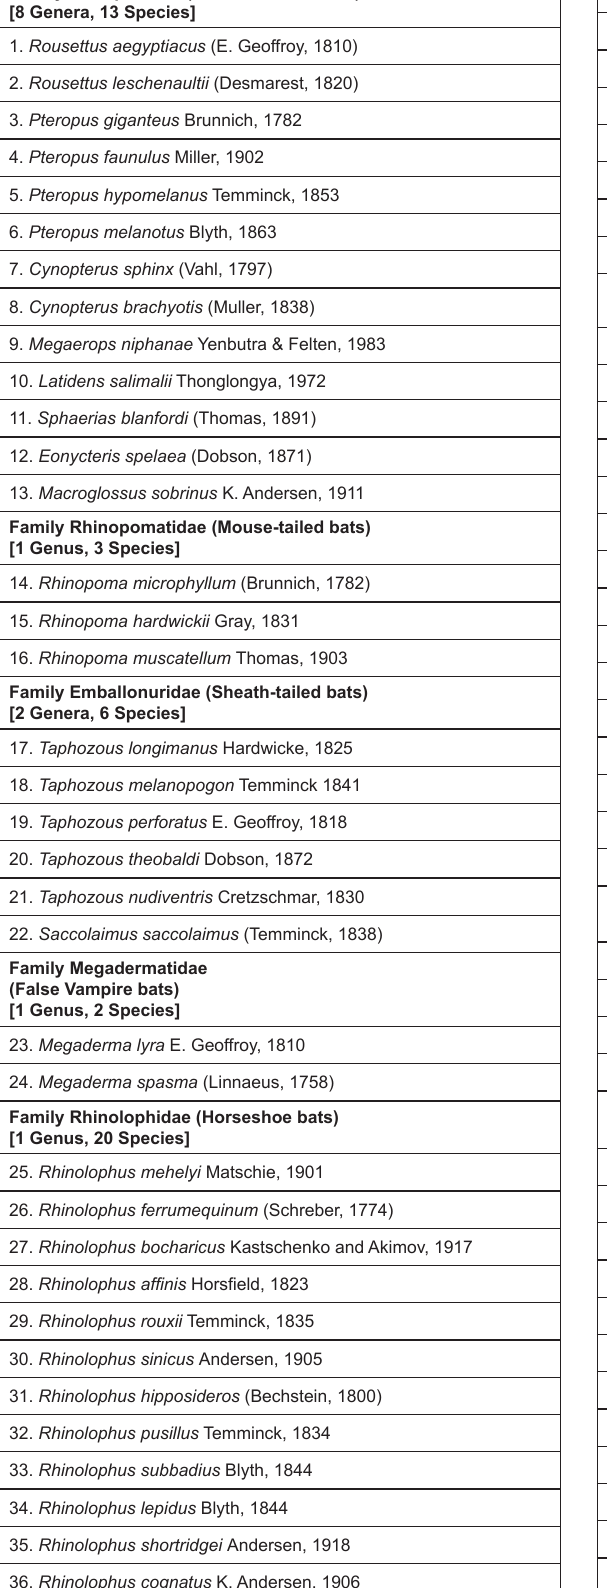
Table 2. Checklist of bats of South